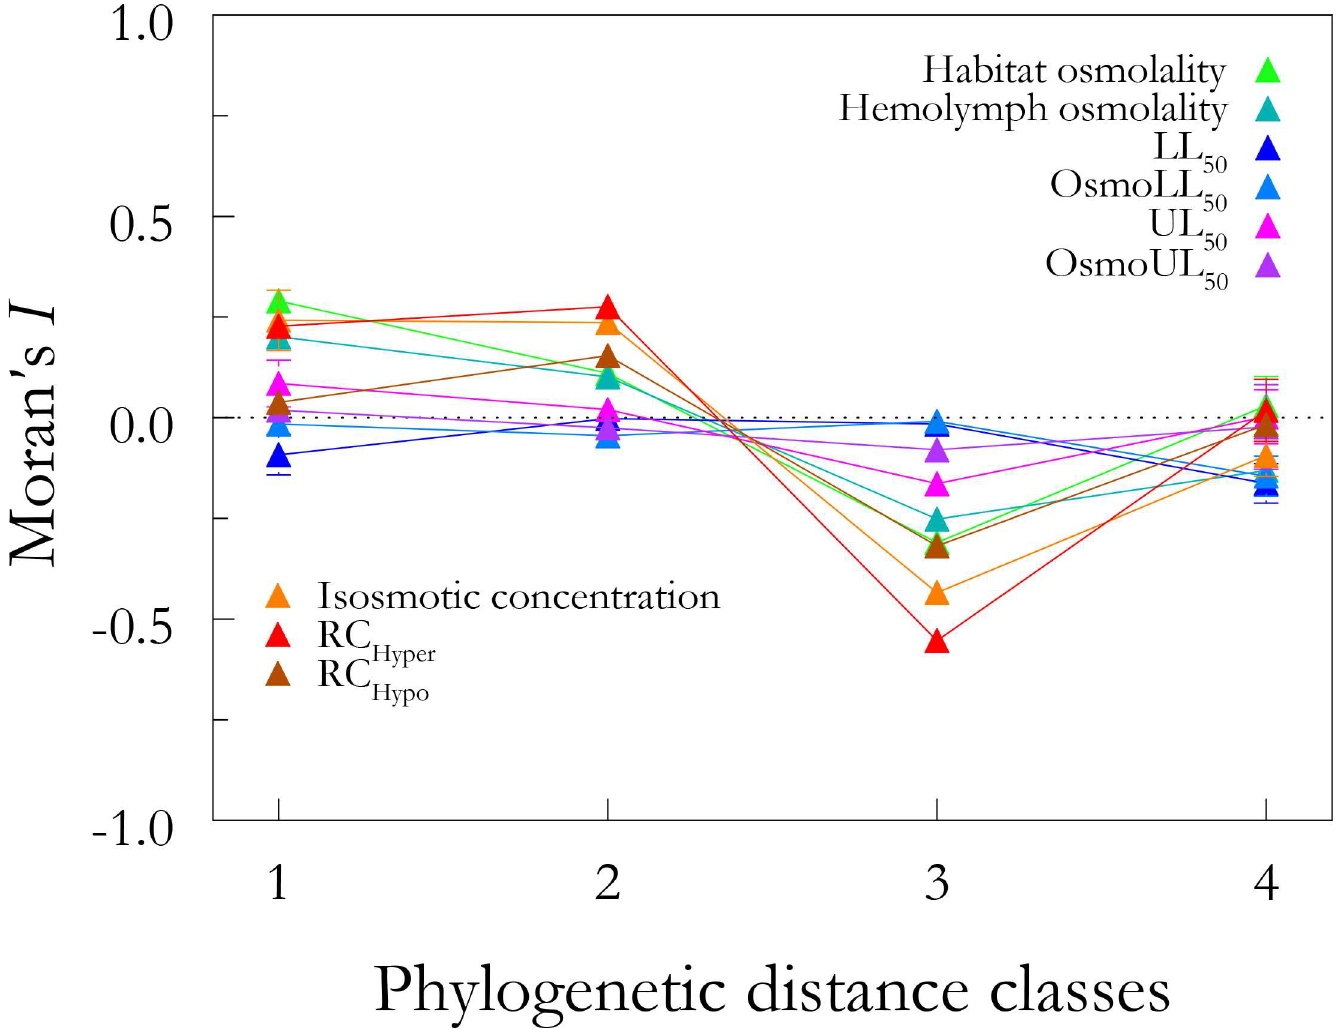
Fig 3. Phylogenetic correlogram showing Moran’s I coefficients for 9 osmoregulatory traits at 4 distance classesin the Uca phylogeny modified from Shih et al. (2015). Horizontalline at I = 0.0 indicatesthe expectedvalue under the null hypothesisof no autocorrelation. Habitat and hemolymph osmolalities, isosmotic concentration and hyper-osmoregulatoryindex (RC Hyper ) showedpositive autocorrelation for the first and second distanceclasses, shifting to either negative or no autocorrelation for the other two classes, demonstrating strong phylogenetic structuring. However, traits associatedwith the lower (LL 50 ) and upper (UL 50 ) lethal limits, and their respectivehemolymphosmolalities (Osm LL50 , Osm UL50 ) and with hypo-osmoregulatory capacity (RC Hypo ) do not correlate significantly with phylogeny for any